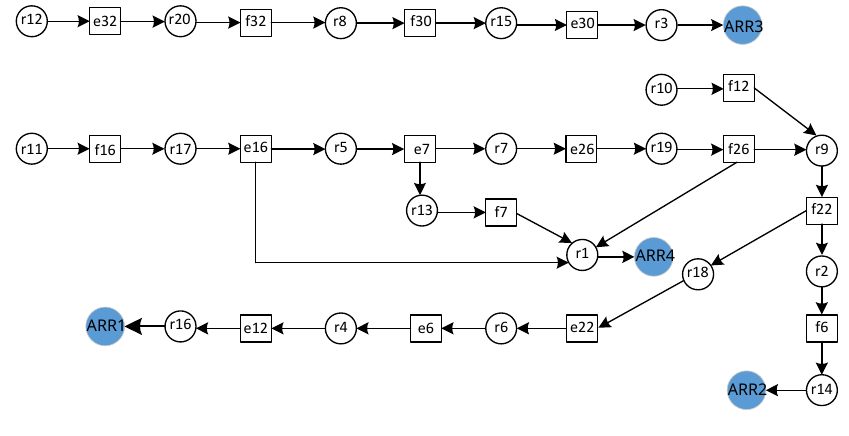
Figure 11. Alternated chain deduced from M .